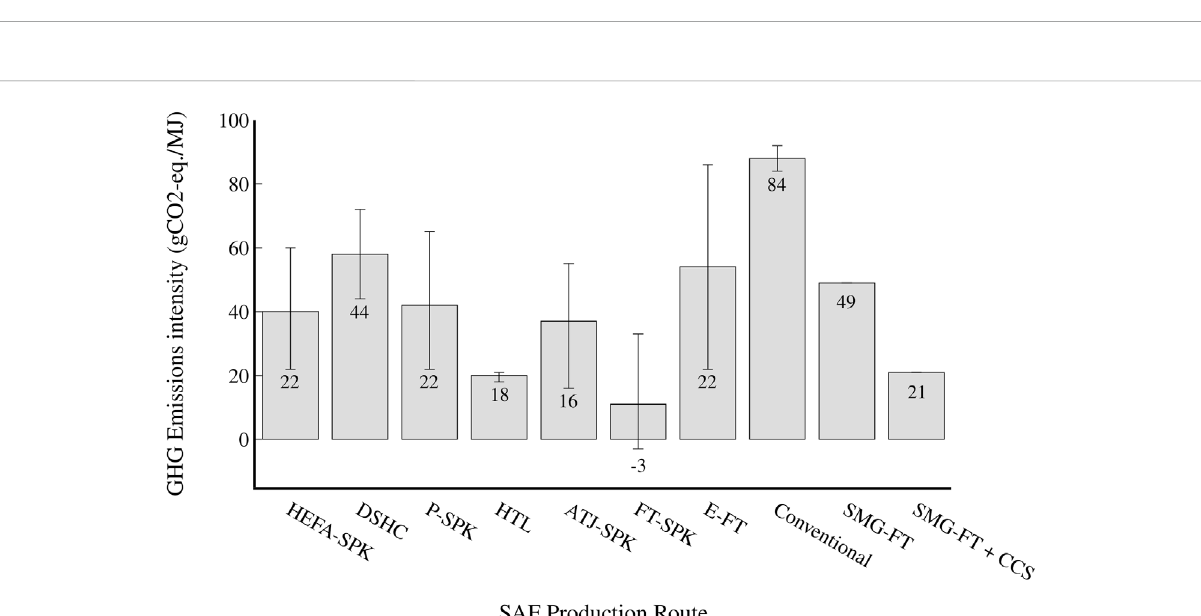
FIGURE 9 GHG emissions intensity (gCO 2 -eq./MJ jet fuel) of the various SAF benchmarks (see section 3.1) and conventional aviation fuel. The grey bar represents the median GHG emissions found for each process route among studies, while the error bars correspond to the lowest and highest GHG emissions found for each process route. The text states the lowest found GHG emissions for each SAF production route. A capture rate of 90% is assumed for the CCS